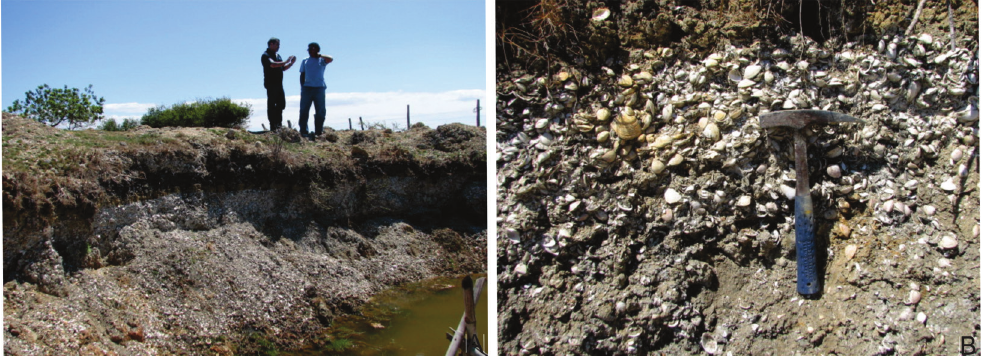
Figure 5 - Overview of mollusk shell deposits dated at 5287 – 5573 cal yr BP (sample HRHML / LAGECOST 1455, Table I) Malhada Marsh, Cabo Frio - southeastern